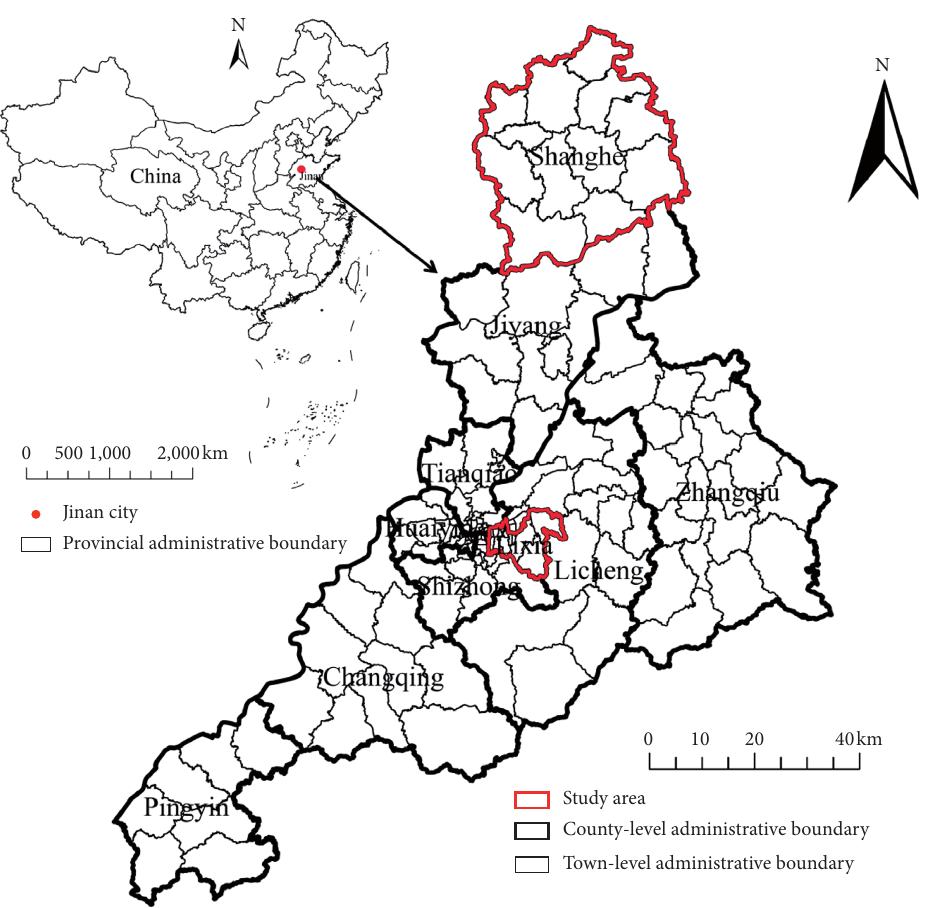
Figure 1: Location map of the study area.